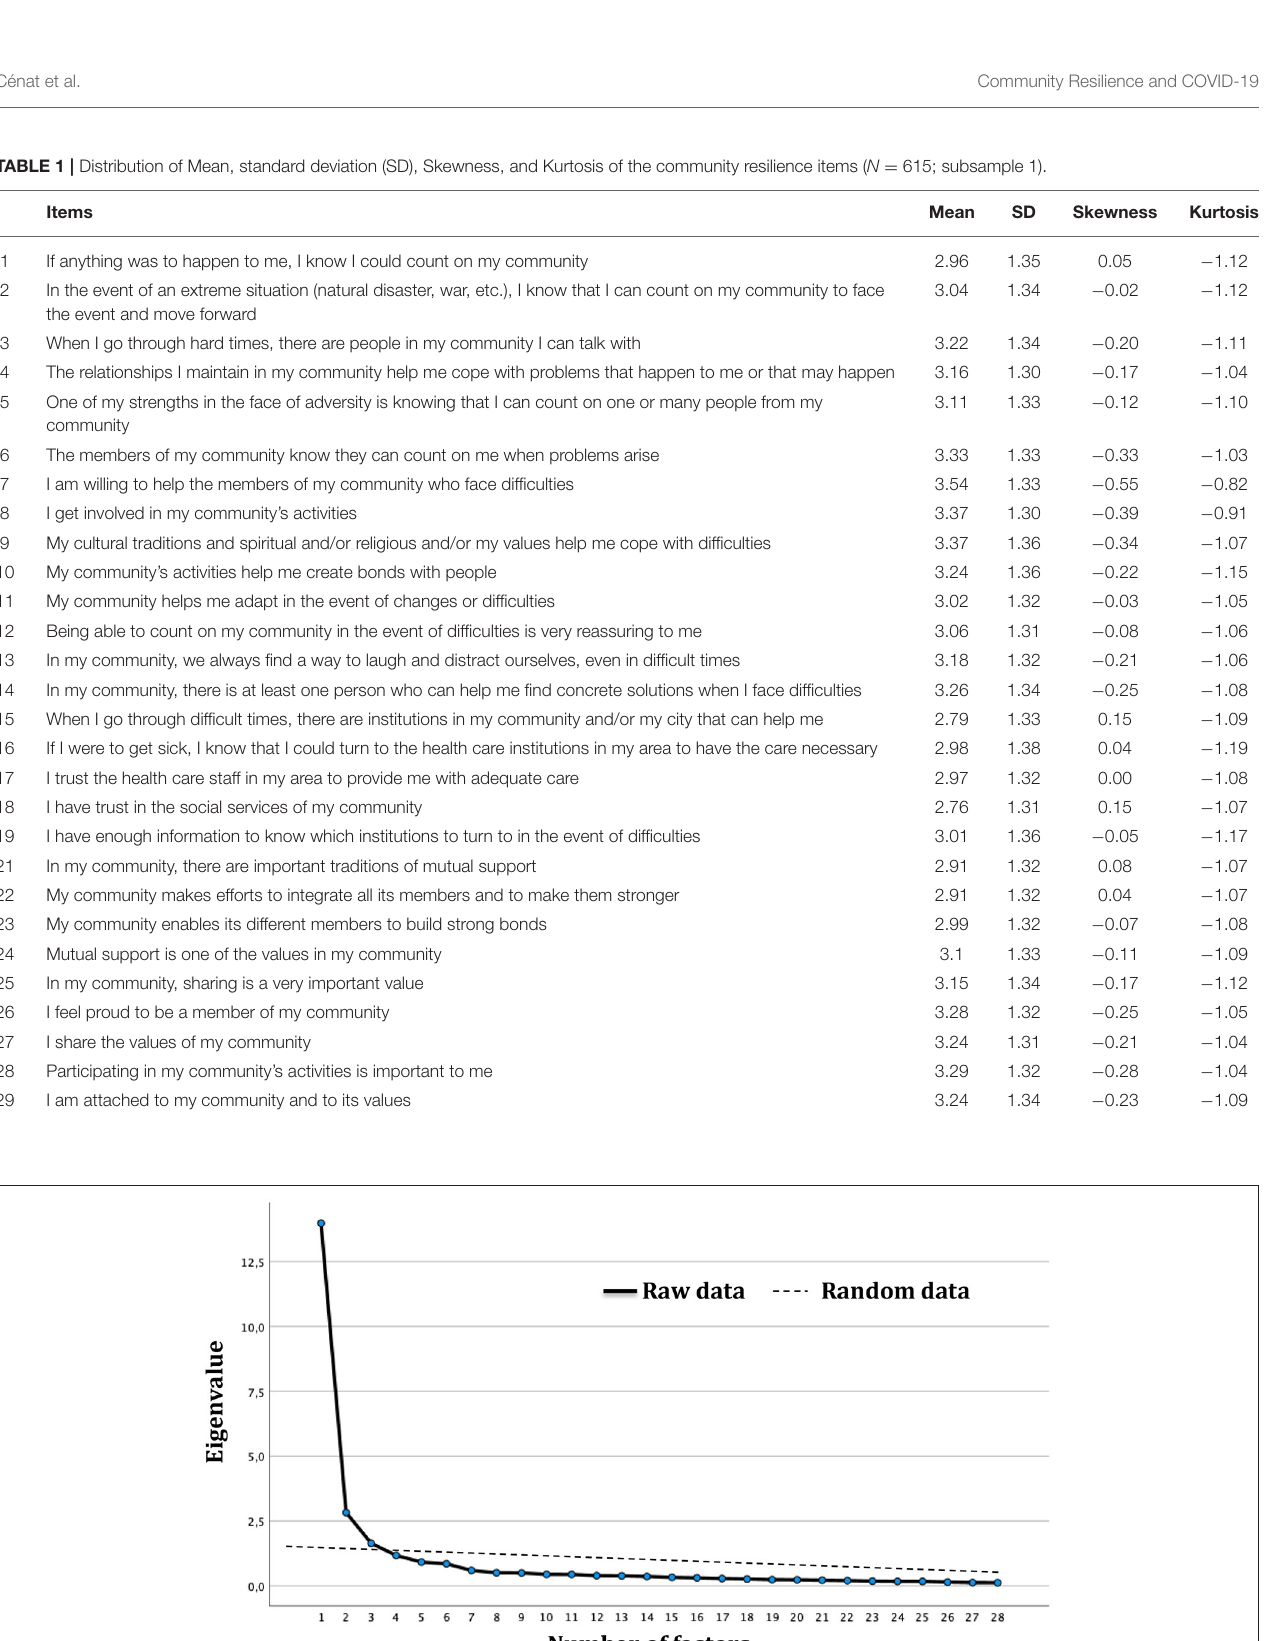
Frontiers in Psychology |